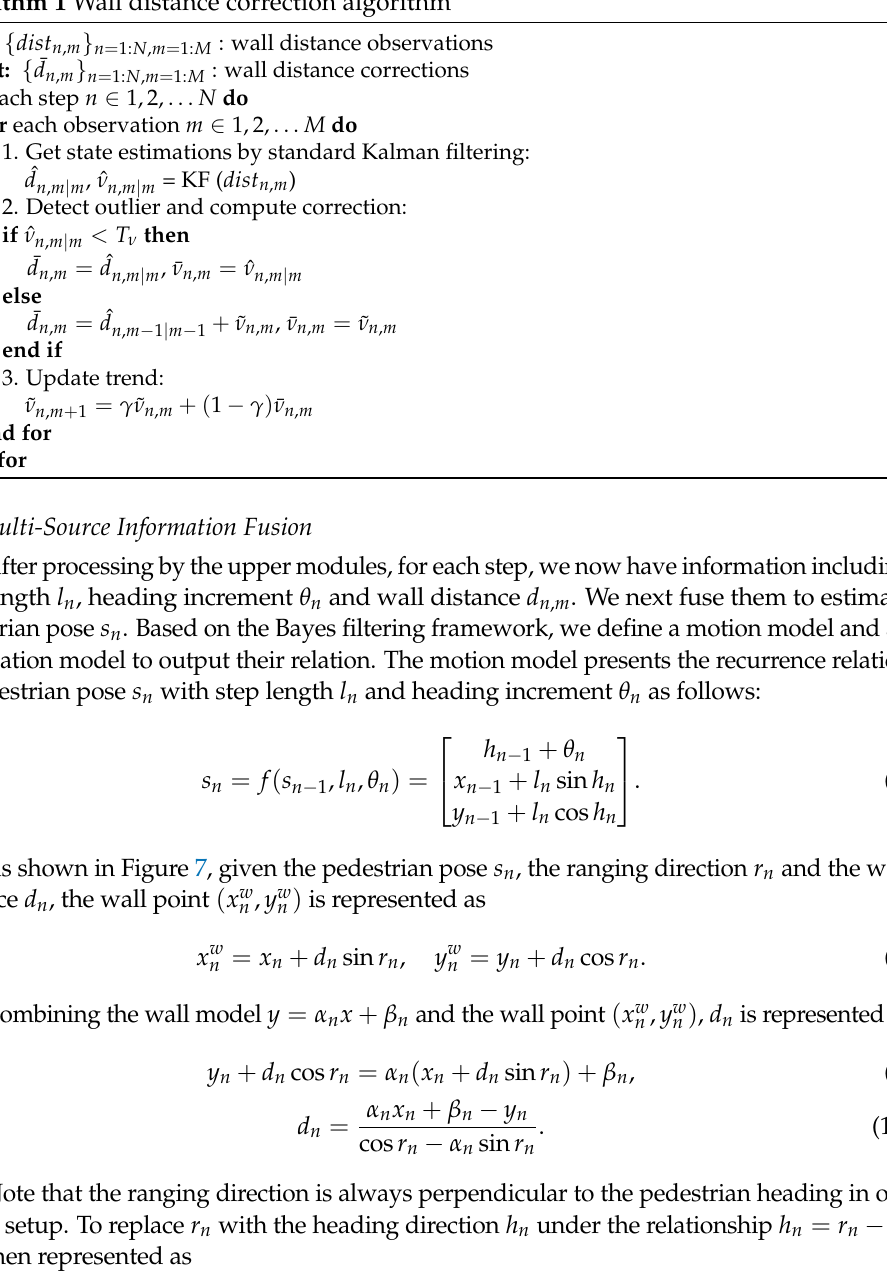
Algorithm 1 Wall distance correction